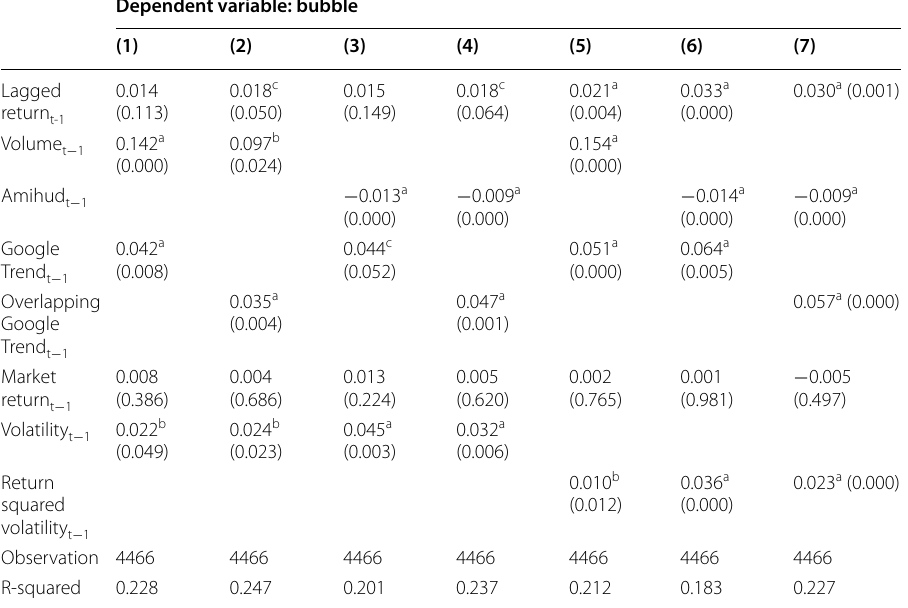
Table 10 Robustness